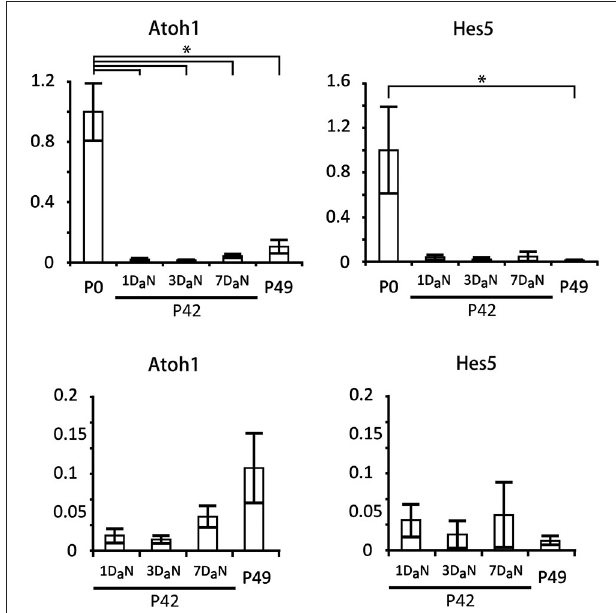
FIGURE 7 | Hes5 and Atoh1 remain expressed at very low levels in the mature organ of Corti, even after noise damage . Relative expression of Atoh1 and Hes5 obtained by QPCR in cochlear explants from neonatal (P0) and 6 to 7 week old mice exposed to noise. The mice exposed to noise on the 42nd postnatal day (P42) were evaluated after 1 (1D a N), 3 (3D a N), or 7 (7D a N), days. As controls for the 7 day cohort we used 7 week old mice (P49) that had never been exposed to noise. The expression levels of Atoh1 and Hes5 were normalized to the level of expression at P0. N = 3 in all cases except P0, where N = 6. The values for adult animals are re-plotted on separate graphs; note that no significant changes occur in the adult samples. Error bars: SEM. * p = 0.03689 (Mann-Whitney pairwise